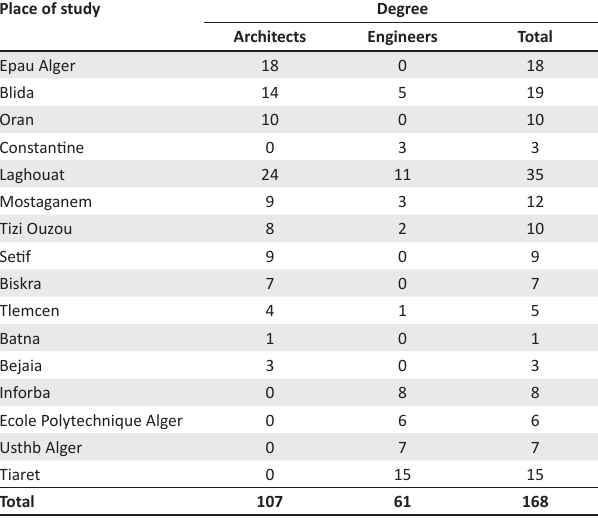
TABLE 1: High education place of study of architects and engineers.